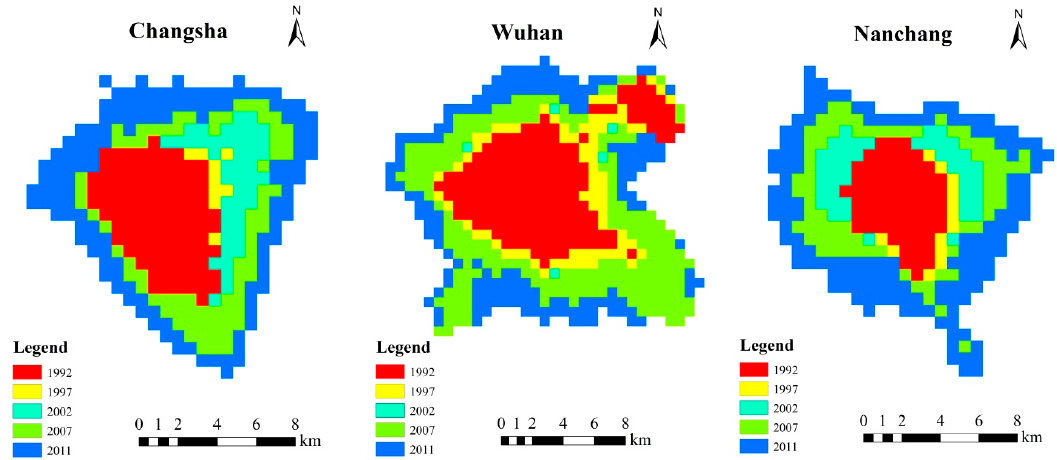
Figure 10. Urban expansion in three provincial capital cities in the MRYR from 1992 to 2011.